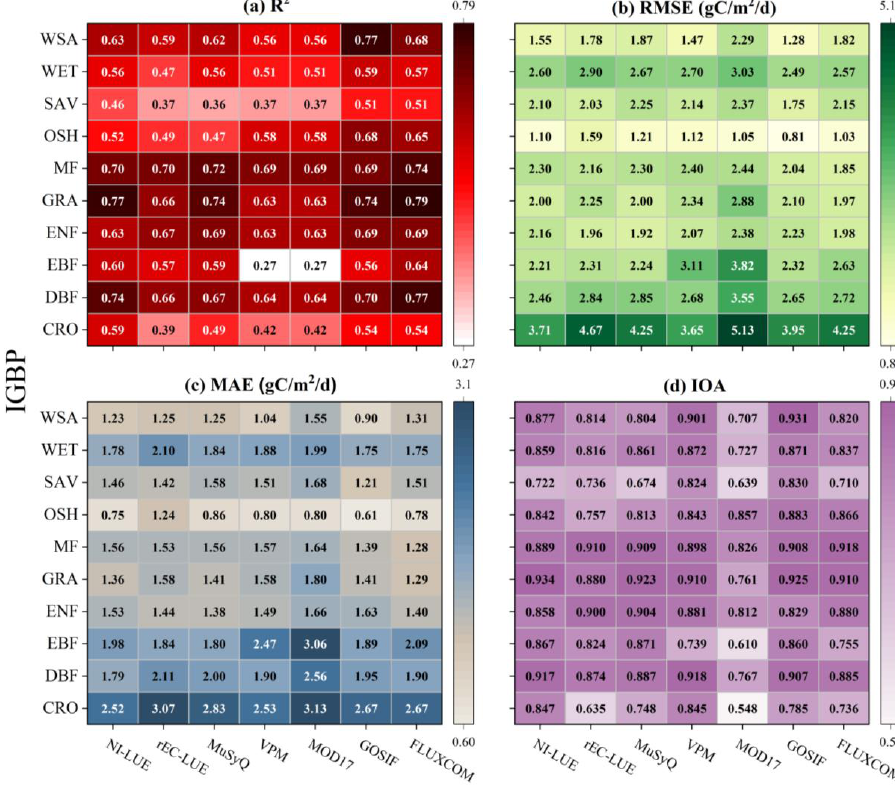
Figure 11. Comparison of simulation accuracy of various GPP products for different vegetation types at 8-day time scales.